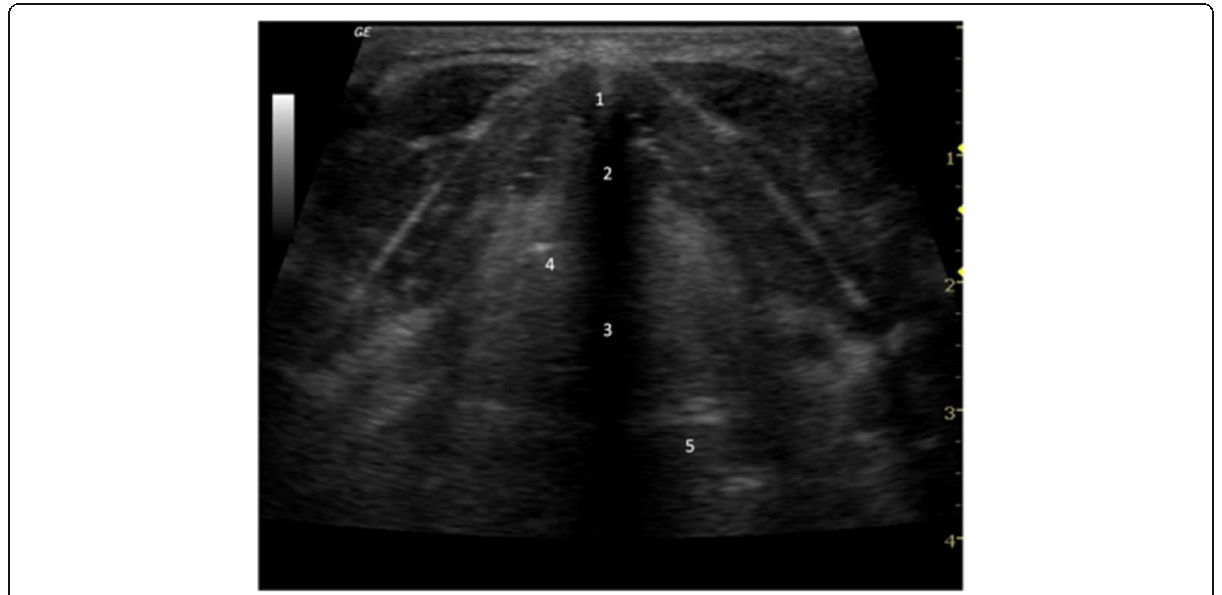
Fig. 2 Another ultrasound photo of one of our patients showing a different group of laryngeal structures: 1 — anterior commissure, 2 — anterior part of vibrating vocal fold, 3 — posterior part of vibrating vocal fold, 4 — thyroarytenoid muscle, 5 — posterior cricoid